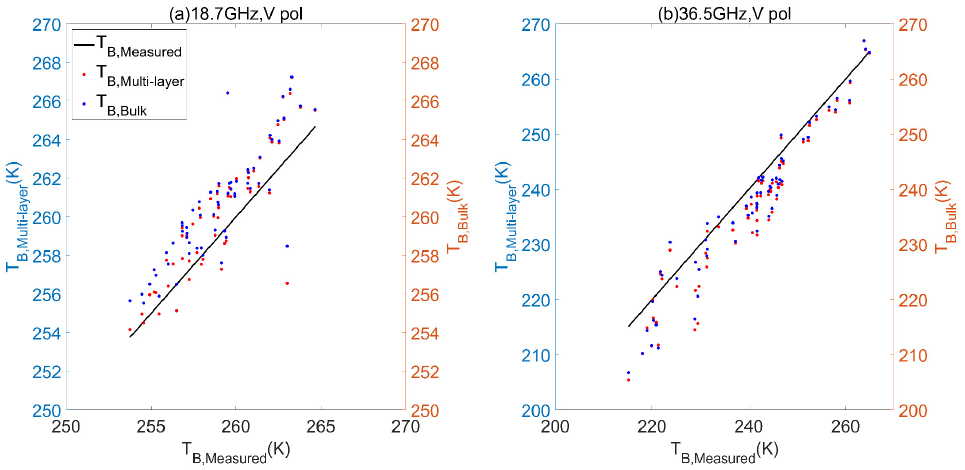
Table 7. Error statistics for the MEMLS-simulated multiple-layer brightness temperature (T B,Multi-